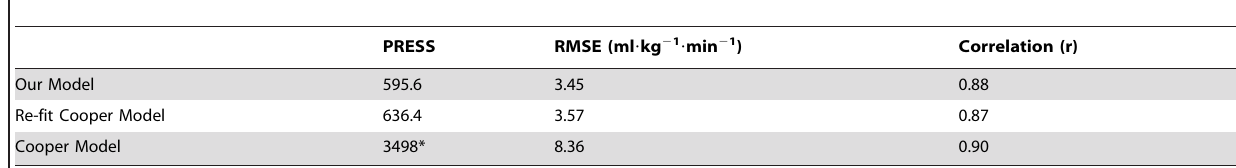
Table 2. PRESS statistic, RMSE, and correlation coefficients for our model, the re-fit Cooper model, and the Cooper model.